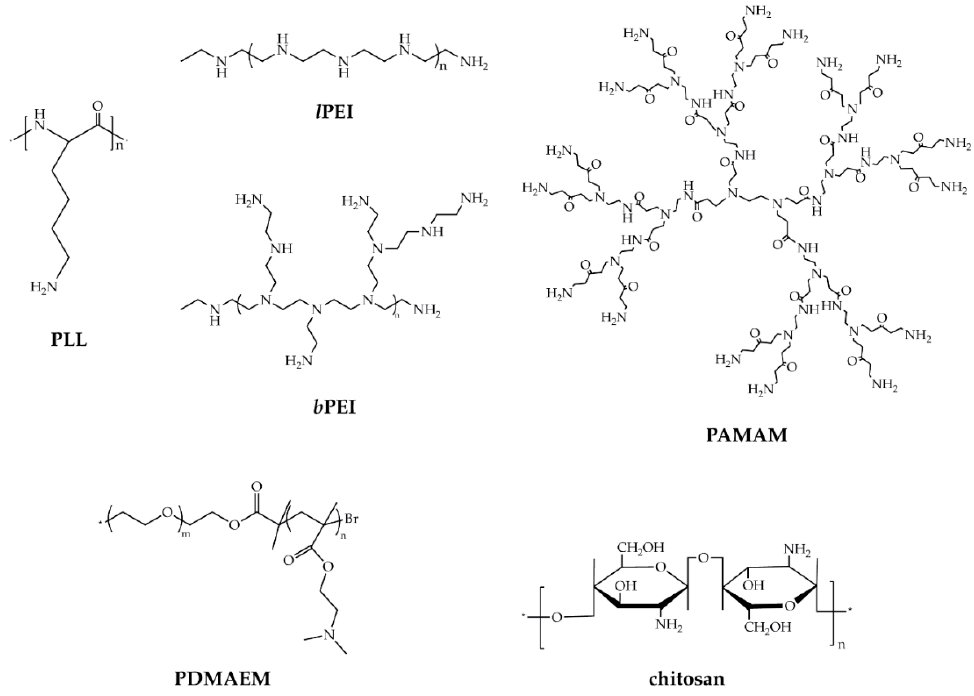
Figure 2. Chemical structures of commonly used cationic polymers for gene delivery purposes.